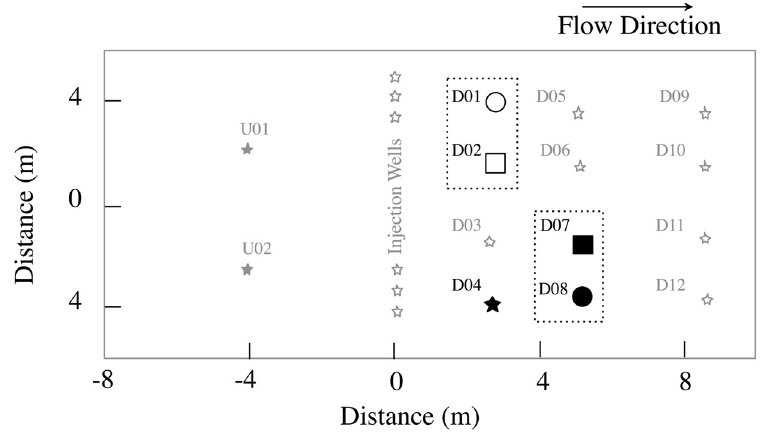
Fig 1. Map of the field site indicating the wells used for this